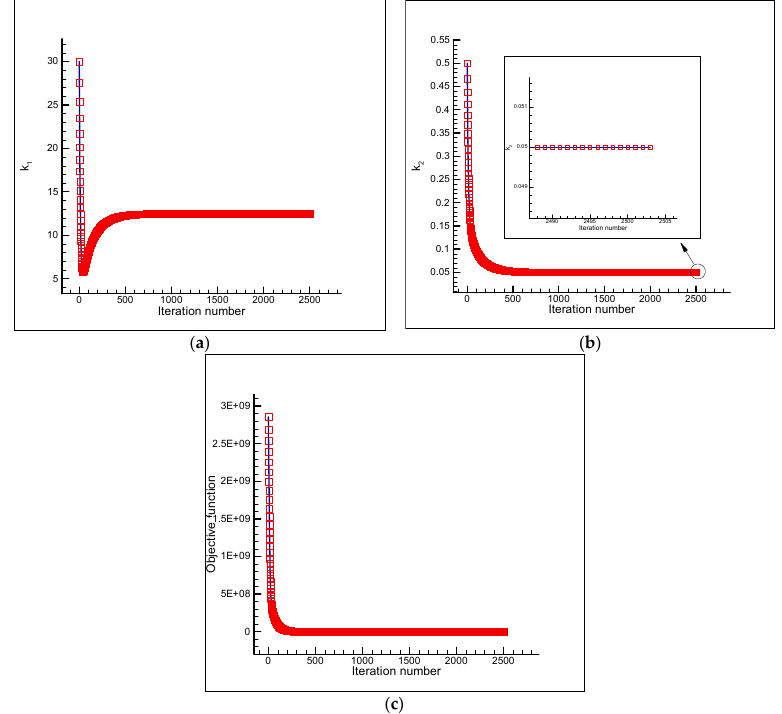
Figure 14. Estimation of k 1 ( a ) and k 2 ( b ), and the objective function versus iteration number ( c ) using the initial guess = 30.0 + 0.5 T ( W ) and a single sensor placed at the node ( i , j ) = ( 18,8 ) k T m. ◦ C initial 1